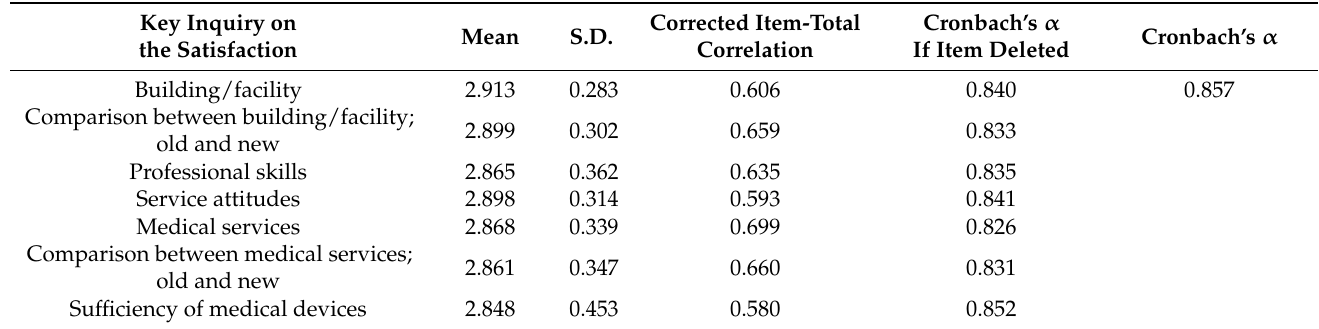
Table 3. Reliability index of patient satisfaction-relevant key inquiry with regards to the three indicators (CHS building/facilities, professional skills and service attitudes of the CHS medical personnel, as well as the medical services offered by CHSs).